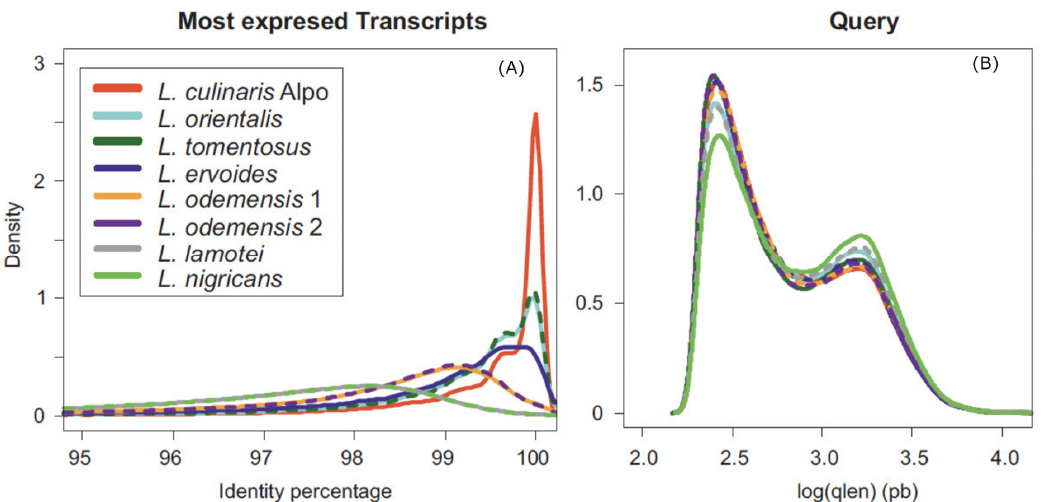
Figure 3. Density functions. ( A ) Density functions for the eight accessions (y-axis) are plotted against the percentage of identity between the most expressed transcripts of each accession and the Lens culinaris reference CDC Redberry. ( B ) Density functions of the length of the alignments between each query and CDC Redberry.